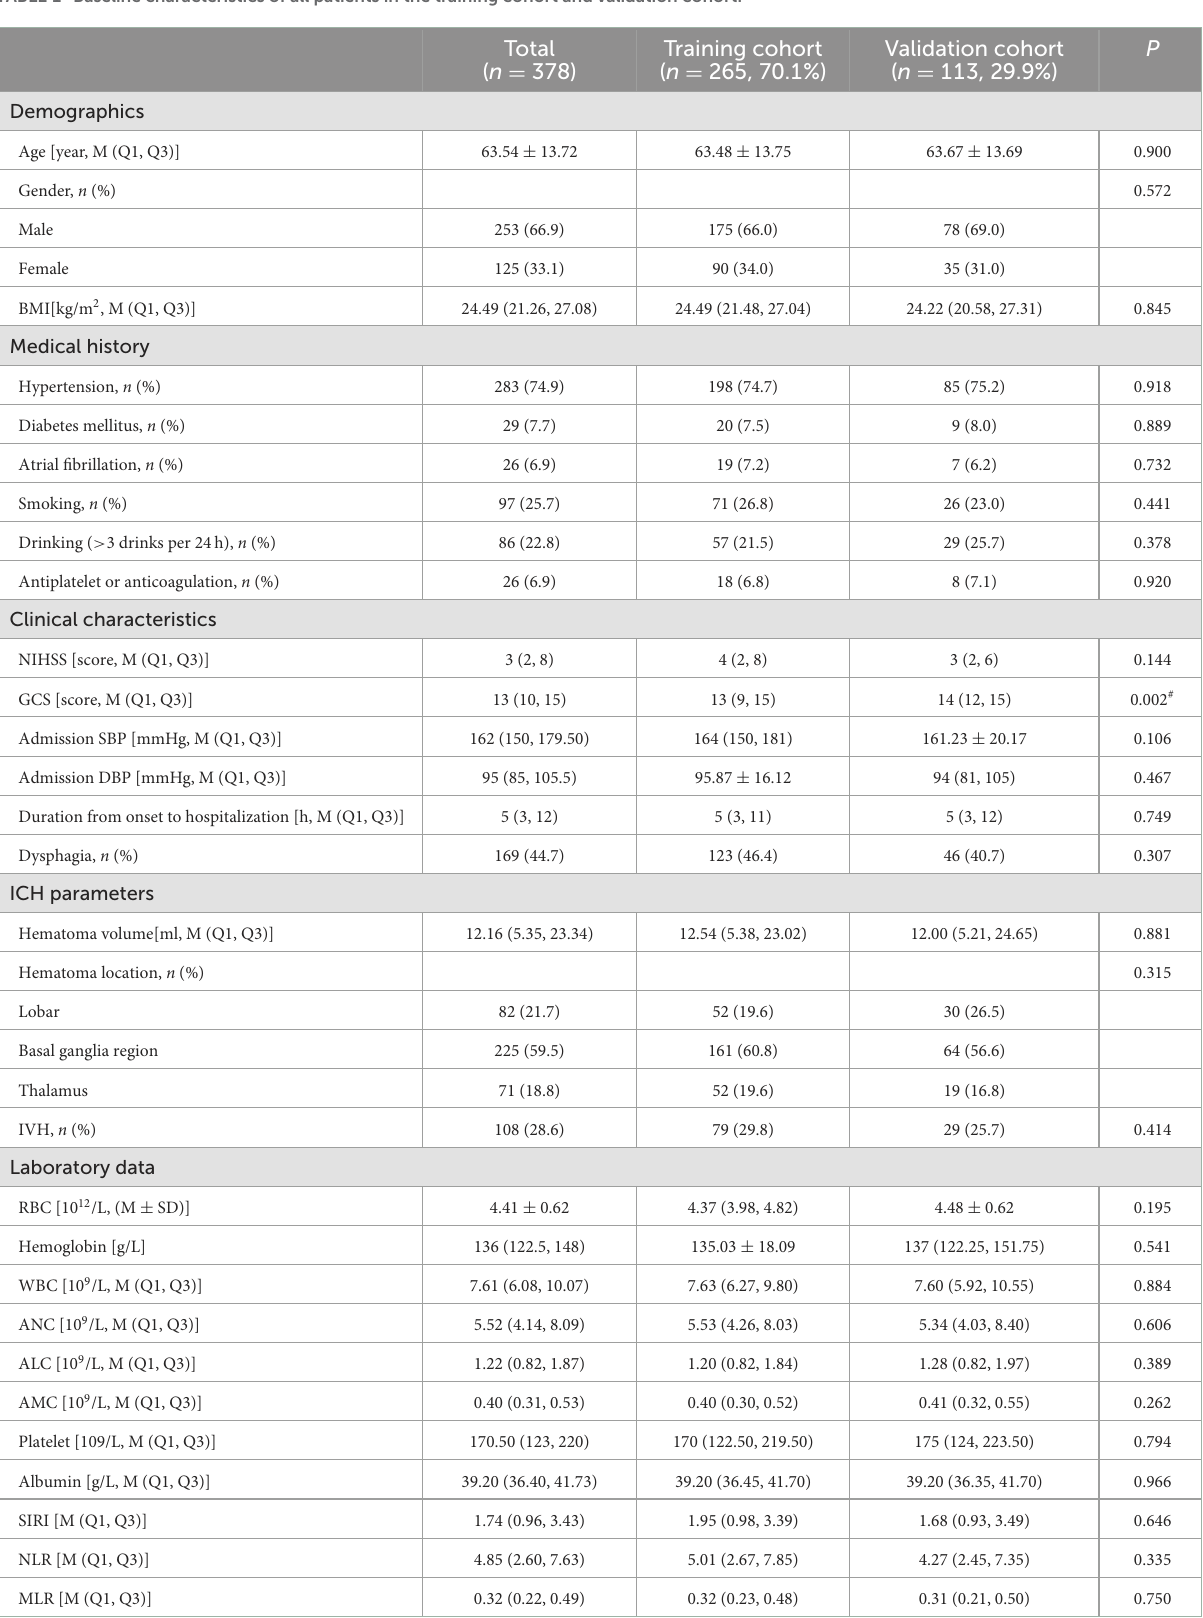
TABLE 1 Baseline characteristics of all patients in the training cohort and validation cohort.